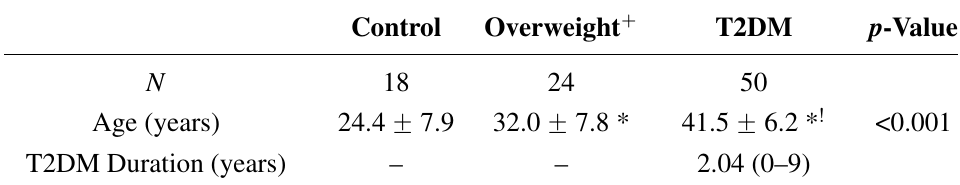
Table 1. Clinical and metabolic characteristics of subjects according to